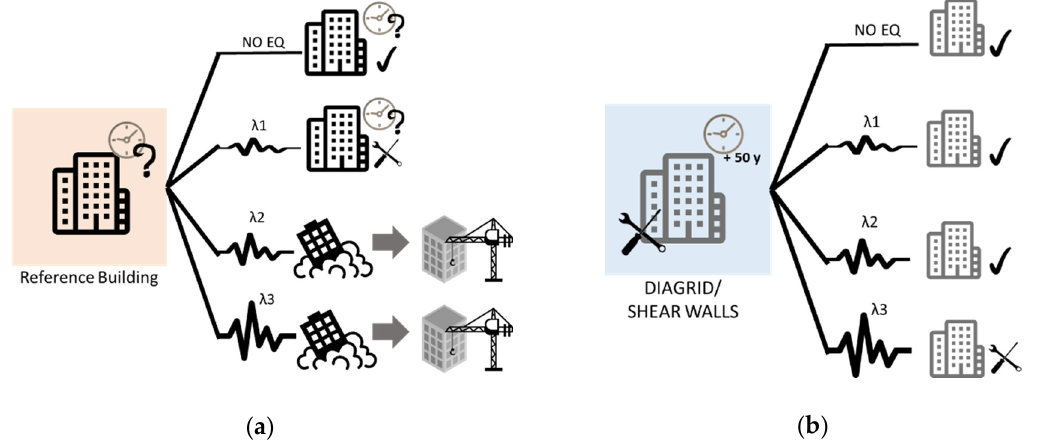
Figure 5. Future scenarios depending on the building quality: ( a ) not-retrofitted reference building; ( b ) retrofitted reference building.